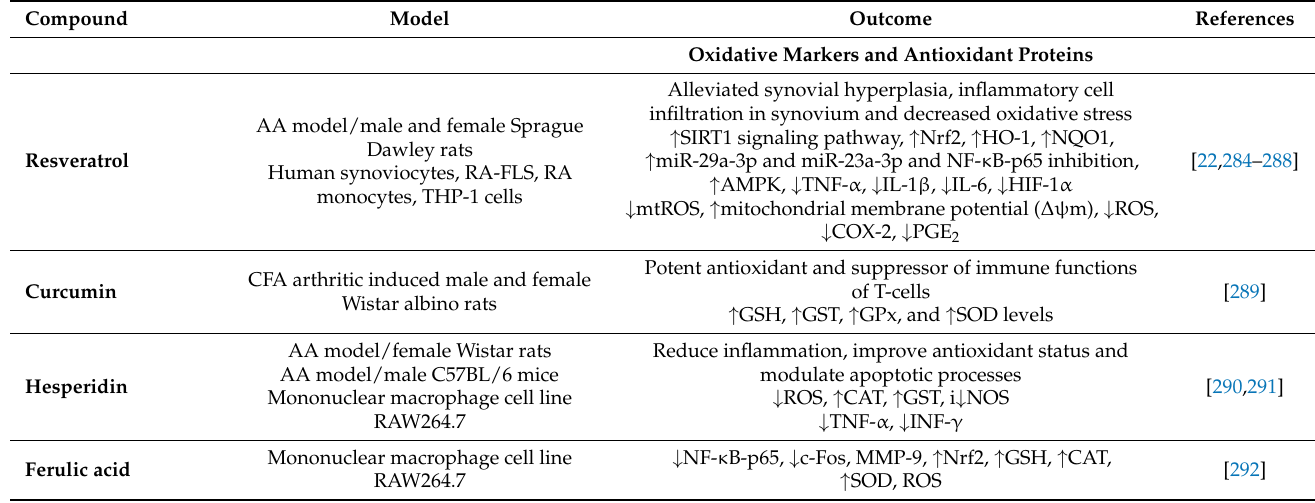
Table 1. Natural compounds with beneficial effects on oxidative damage and inflammatory response in